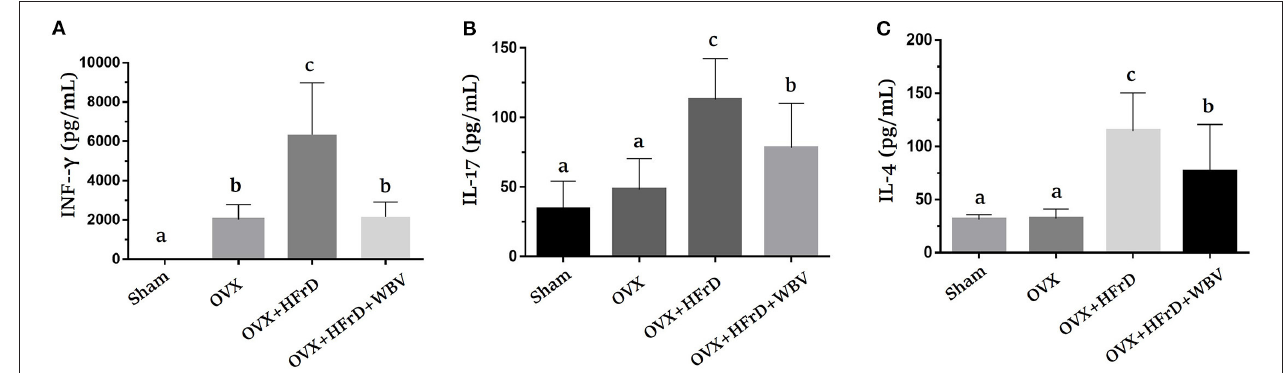
FIGURE 6 | The effects of whole-body vibration (WBV) combined with a high-fructose diet (HFrD) on ovariectomized (OVX) mice in terms of Th1/Th2 cytokines in Con A-stimulated splenocytes. The splenocytes were isolated from mice immediately after sacrifice. The cell density was adjusted to ensure the uniformity of culture conditions, with 2.5 µ g/mL Con A stimulation for IFN- γ (A) , IL-17 (B) , and IL-4 (C) cytokines. Data are presented as means ± SD. Different superscript letters indicate significant differences ( P < 0.05), as indicated by a one-way analysis of